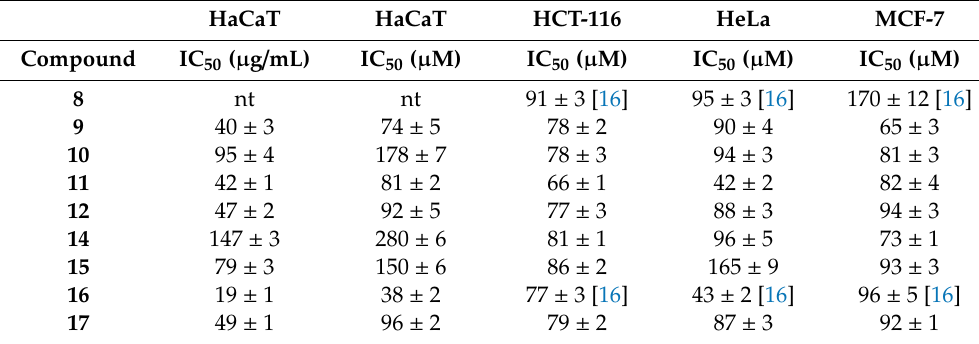
Table 5. IC 50 for compounds 9 – 12, 14 – 17 obtained in the MTT test a,b